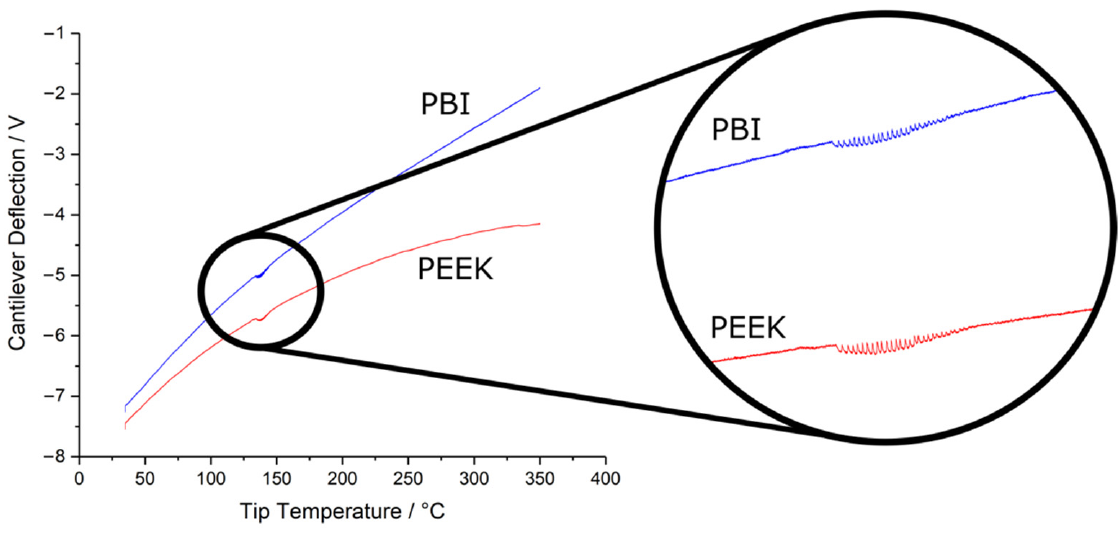
Figure 5. NanoTA analysis of microtomed sections of PEEK and PBI. Average temperature profiles of each material with the regions showing water release fringes expanded in the inset.